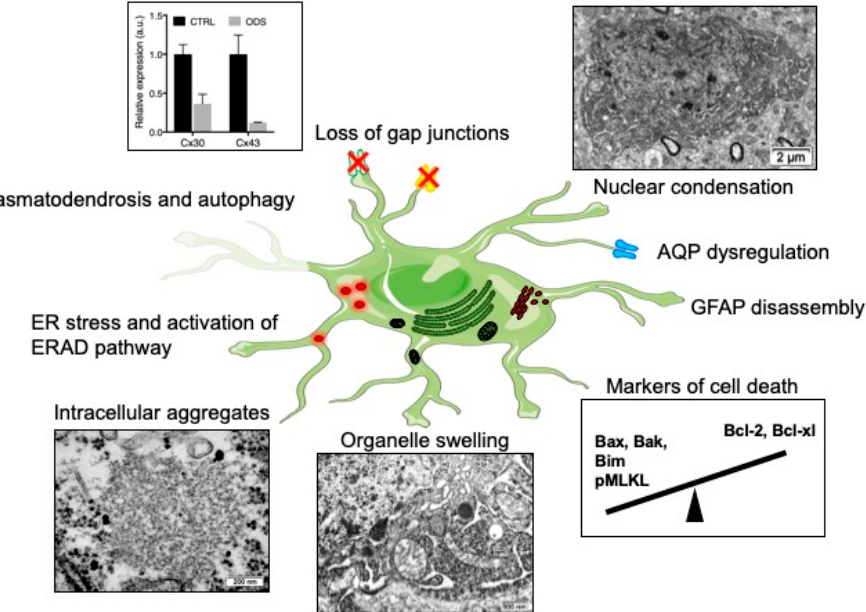
Figure 1. Astrocytopathy during osmotic demyelination. Major changes observed in astrocytes of demyelinating-prone regions include: downregulation of gap junctions (Cx30 and Cx43) [44,48], dysregulation of aquaporin expression (AQP1 and AQP4) [113], ER stress and activation of ER-associated degradation (ERAD) pathway [112], intracytoplasmic aggregates [112,114], swelling of various organelles [44,46,114], loss of GFAP intermediate filaments [6,48], clasmatodendrosis [114], nuclear condensation and upregulation of cell death markers [44,48,72,112].